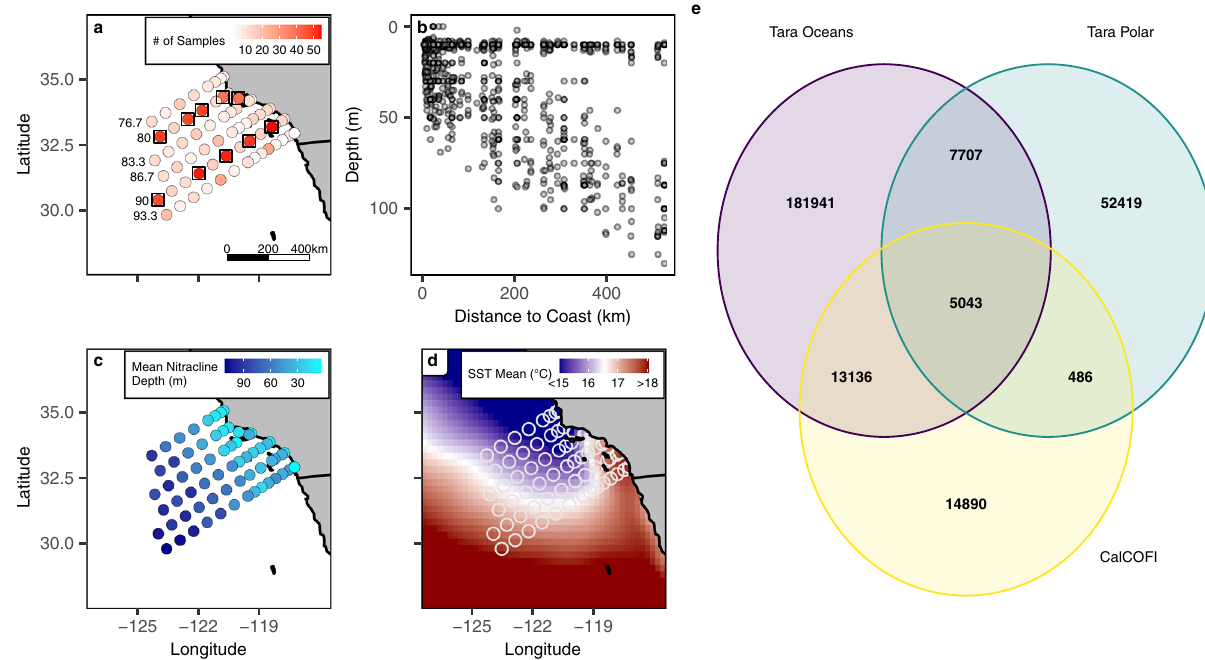
Fig. 1 NCOG sampling and the physical environment of the Southern California Current region. a The number of samples collected at each CalCOFI station from 2014 – 2020. Stations highlighted by squares are the Cardinal Stations (sampled every cruise) ( b ), location of all samples by distance to coast ( X axis) and depth ( Y axis) ( c ), mean nitracline depth (m) measured at each station across all seven years. d Mean SST (°C) from NOAA ’ s OI SST V2 Dataset. White open circles represent the location of CalCOFI stations ( e ), overlap between NCOG 18Sv9 ASVs with those present in Tara Oceans and Tara Polar.